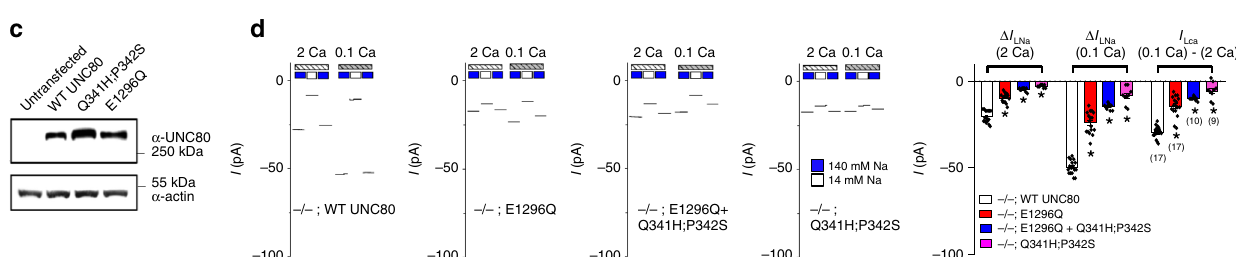
(corresponding to human E1295Q) mutants, blotted with anti-UNC80 antibody (upper) or anti-actin (lower) for loading control. More than three independent repeats were performed with similar results. d TTX-resistant Na + leak current recorded from cultured UNC80 KO hippocampal neurons transfected with wild-type UNC80, E1296Q, Q341H;P342Q, or mixture of the two mutants, as indicated. Representative currents are in the left four subpanels and averaged current amplitudes are summarized in the right. Recordings were from − 70 mV and were done with bath solutions with